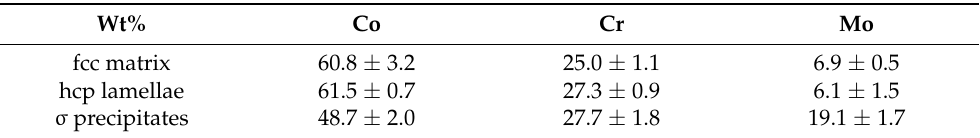
Table 2. Chemical composition of the phases present in the 3D-printed Co-Cr-Mo alloy determined by transmission electron microscopy (TEM)-energy dispersive spectrometry